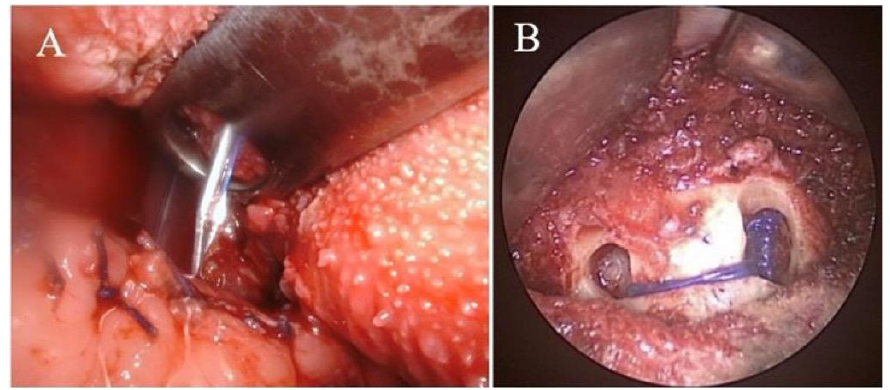
Figure 4. Suture passer emerging from the tongue base ( A ); knots placed inside the hole ( B ) .